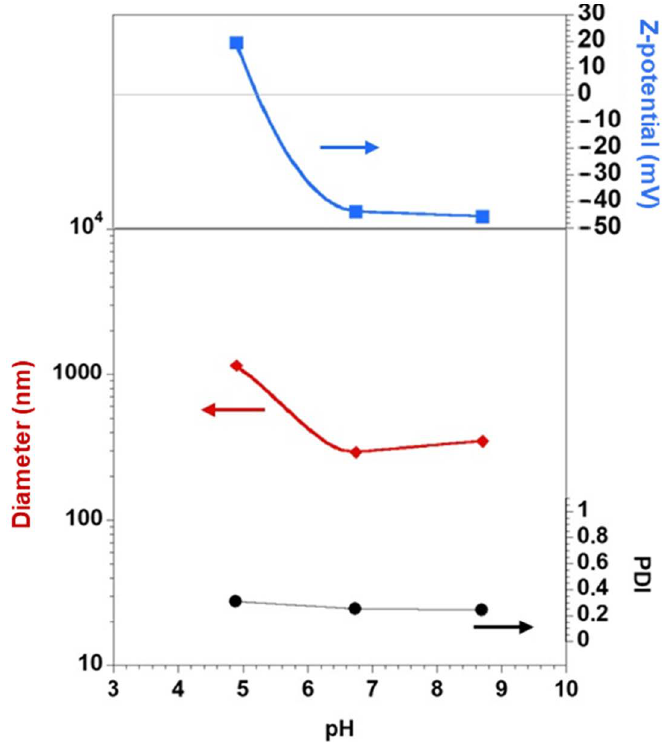
Figure 6. Evolution of the DDAB vesicles surface charge, PDI, and mean size with the deposition of CMC (1 g/L) at different pHs (i.e., 4.9, 6.75, and 8.7) at 25 °C. The average values are found to have a relative standard deviation lower than 3%. Lines are just guides for the eyes.